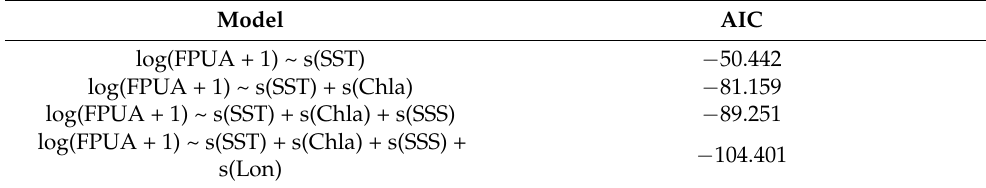
Table 3. Optimal model based on